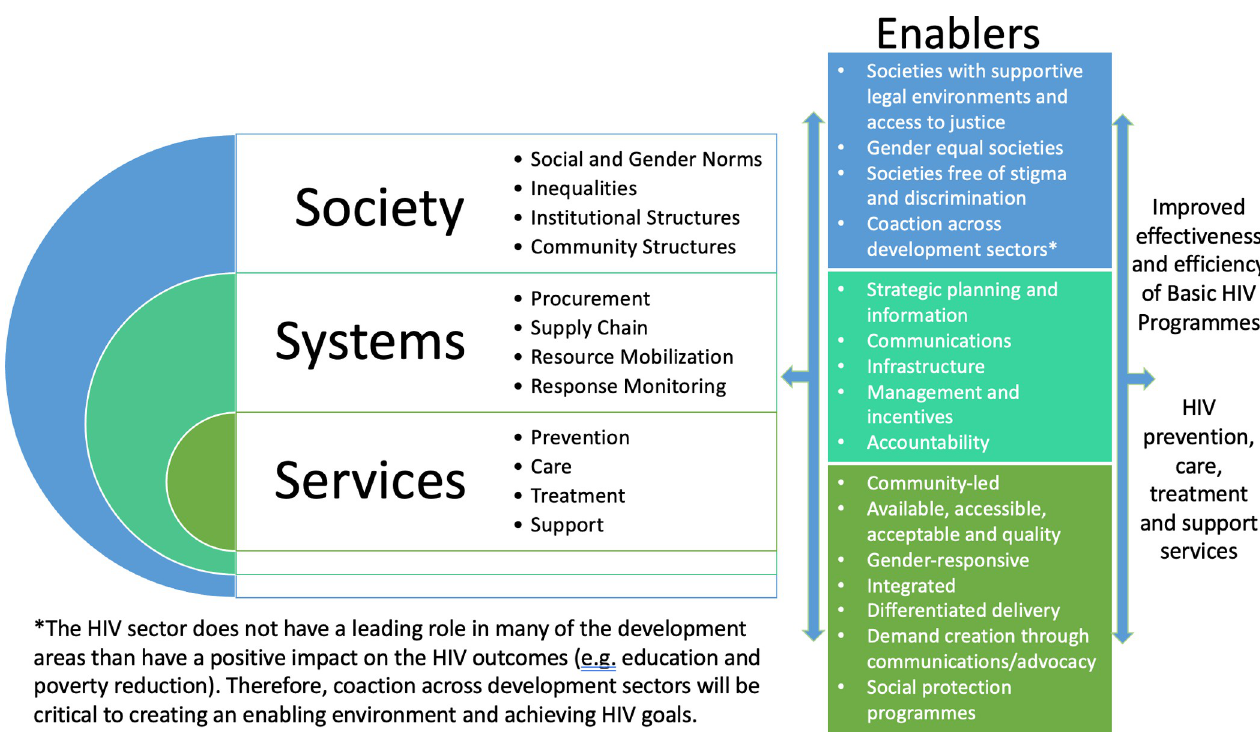
Fig 2. The 3 S’s of the HIV response: A new framework for conceptualising enablers of HIV services and systems and the social environment in which they operate.